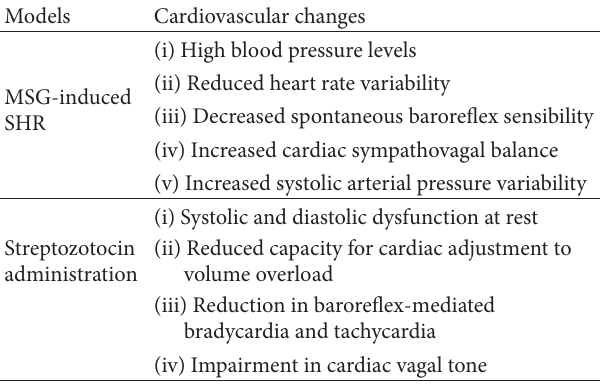
Table 3: Main cardiovascular findings in diet-induced animal models of metabolic